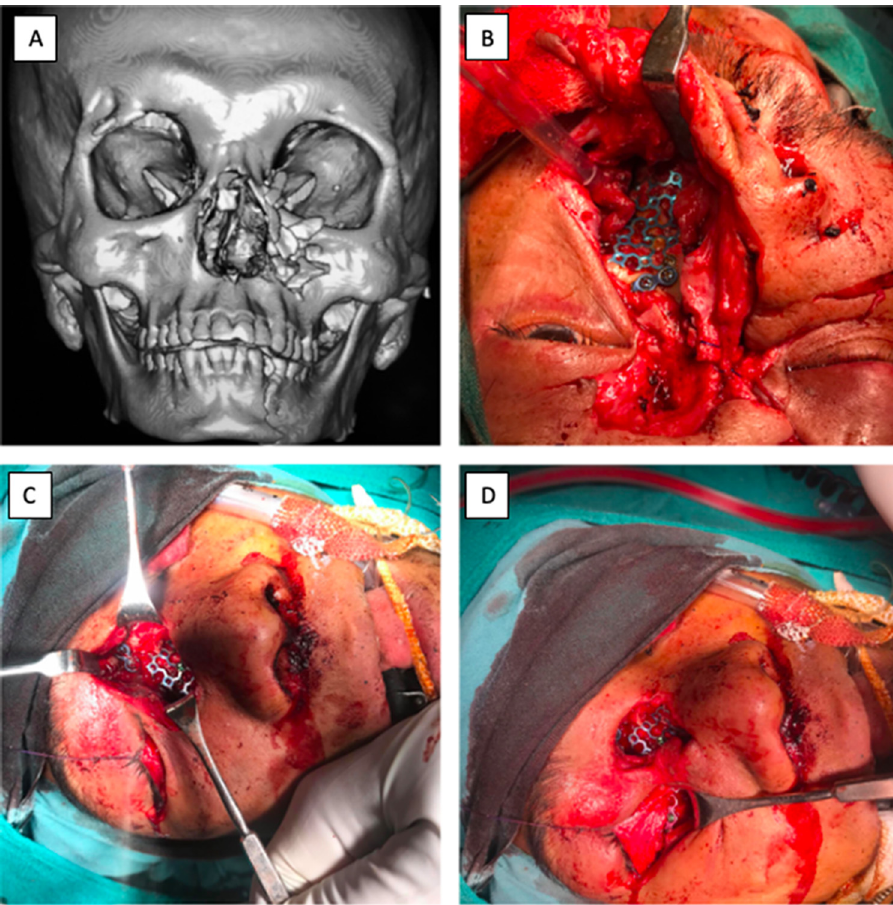
Fig. 4. (A) 3D reformatted CTscan showing comminution of the left lateral nasal wall. (B) Titanium mesh cut and adapted to the left lateral nasal wall and nasomaxillary buttress to hold the minute bone fragments in place. (C) Titanium mesh shaped to span the fractured frontonasal region and (D) spanning the anterior